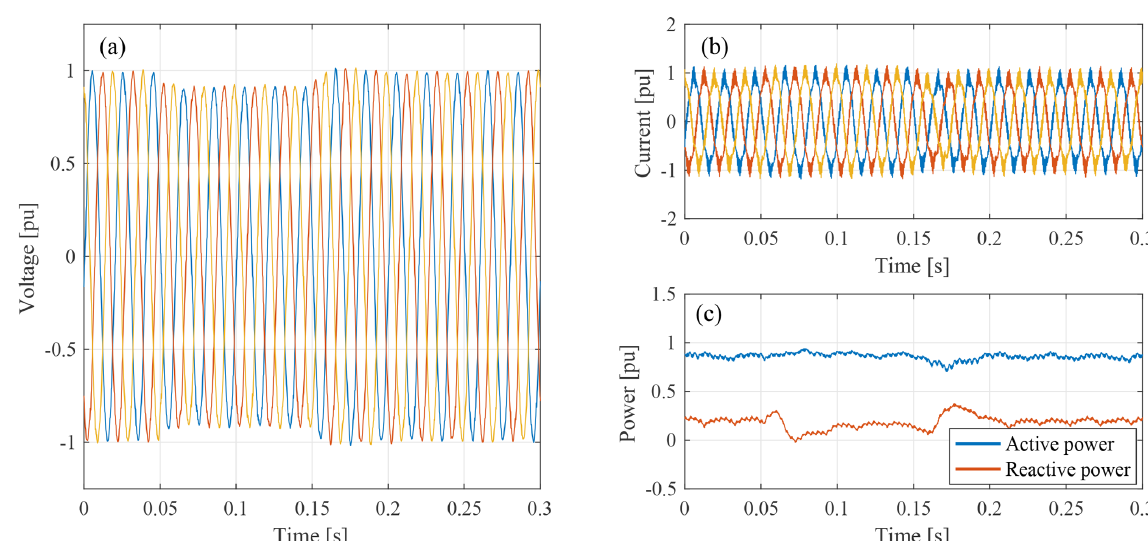
Figure 5. Wind turbine tested for voltage dip at full power production. The figure shows three-phase voltage (a) and current (b) , plus active and reactive power output (c)